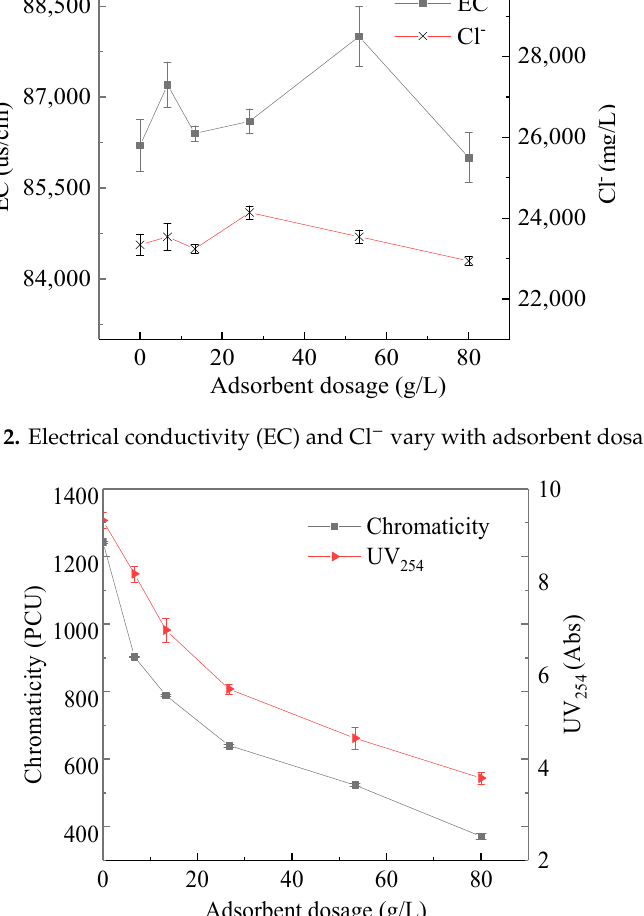
Figure 3 . UV 254 and chromaticity vary with adsorbent dosage.